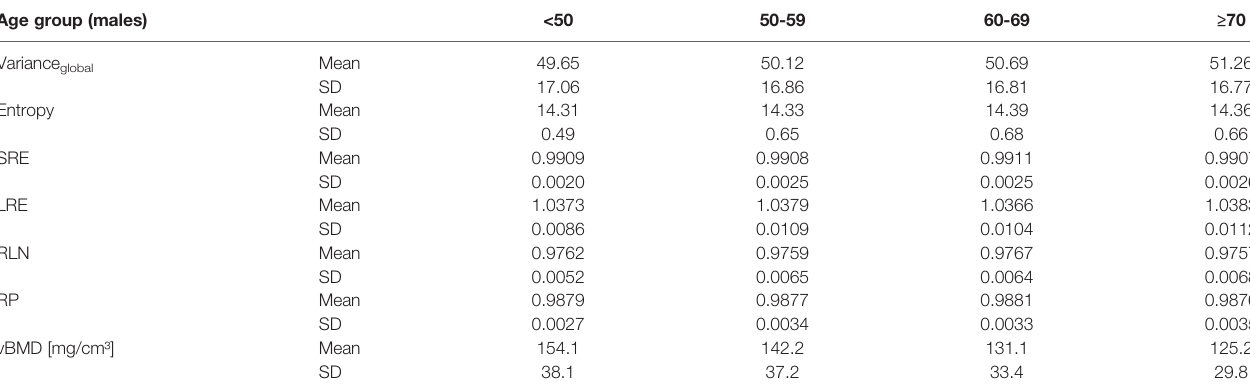
TABLE 7 | Mean and standard deviation (SD) of the six analyzed texture features and vBMD of males, grouped by age group. Age group